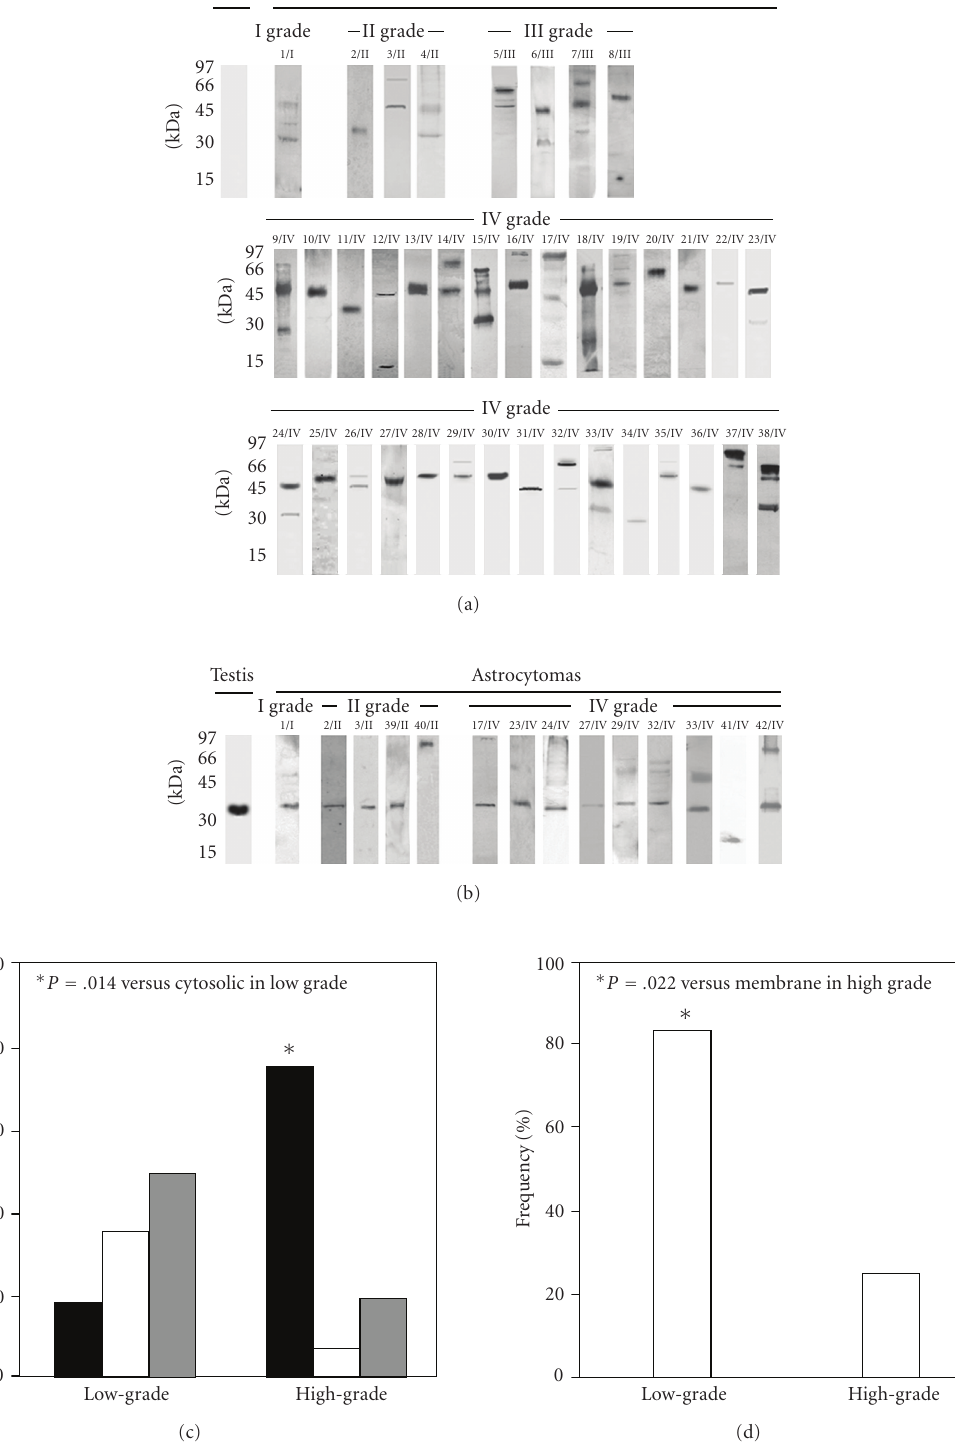
Figure 1: Identification and cellular localization of Dpl in testis and astrocytoma samples. Immunoblotting analysis of cytoplasmic (a) and microsomal (b) fractions. To limit the figure size, only positive samples have been reported. Dpl was detected with the anti-Dpl rabbit antiserum (Dpl-Val) previously described in[10, 11], loading 20 μ g of purified proteins. Each astrocytoma sample is identified by a progressive number followed by their WHO grade of malignancy (1/I, 2/II, etc.). (c) Distribution of Dpl in low- and high-grade astrocytoma samples as a cytoplasmic fraction (black bars), microsomal fraction (white bars) and in both fractions (grey bars). (d) Distribution of microsomal Dpl in low- and high-grade astrocytoma samples, regardless of the presence/absence of the cytosolic protein. Asterisks indicated statistically significant Anova One-way probabilities ( P